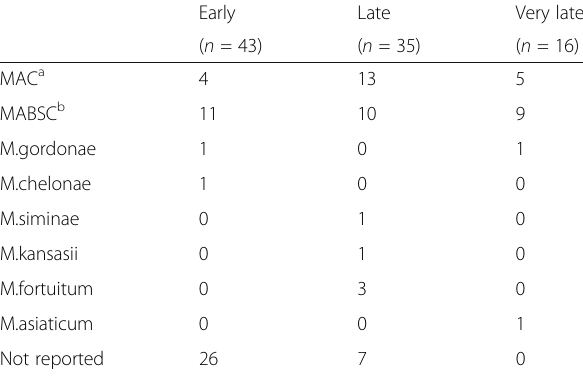
Table 3 Pathogens classified by onset